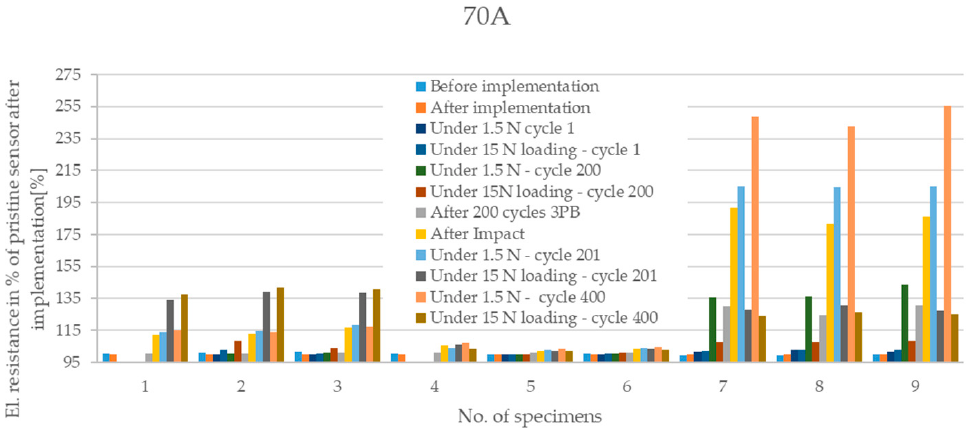
Figure 10. Electrical resistance of integrated sensors as a percentage of the value of a pristine sensor after implementation-results for specimens with CFSs made of material 70 A.